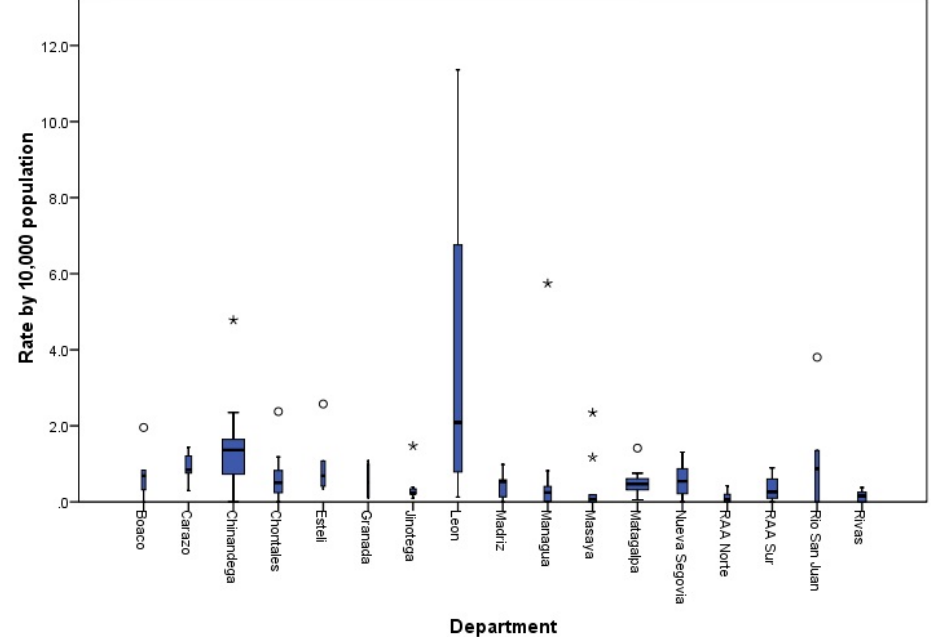
Figure 1. Leptospirosis municipal rates by 10,000 populations, by department, Nicaragua,